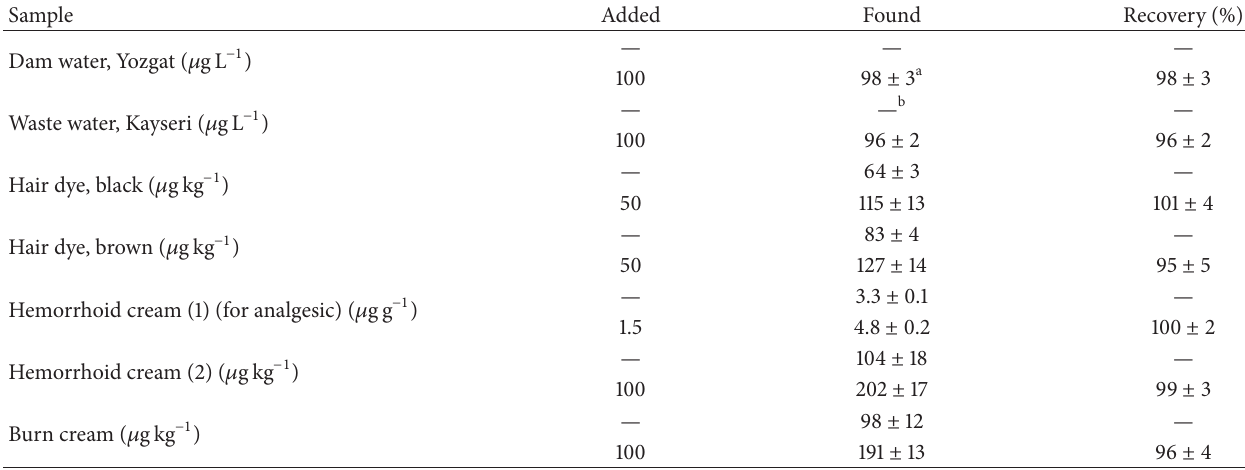
Table 2: The determination of bismuth in water, cream, and hair dye samples ( 𝑛 = 3 ). Sample